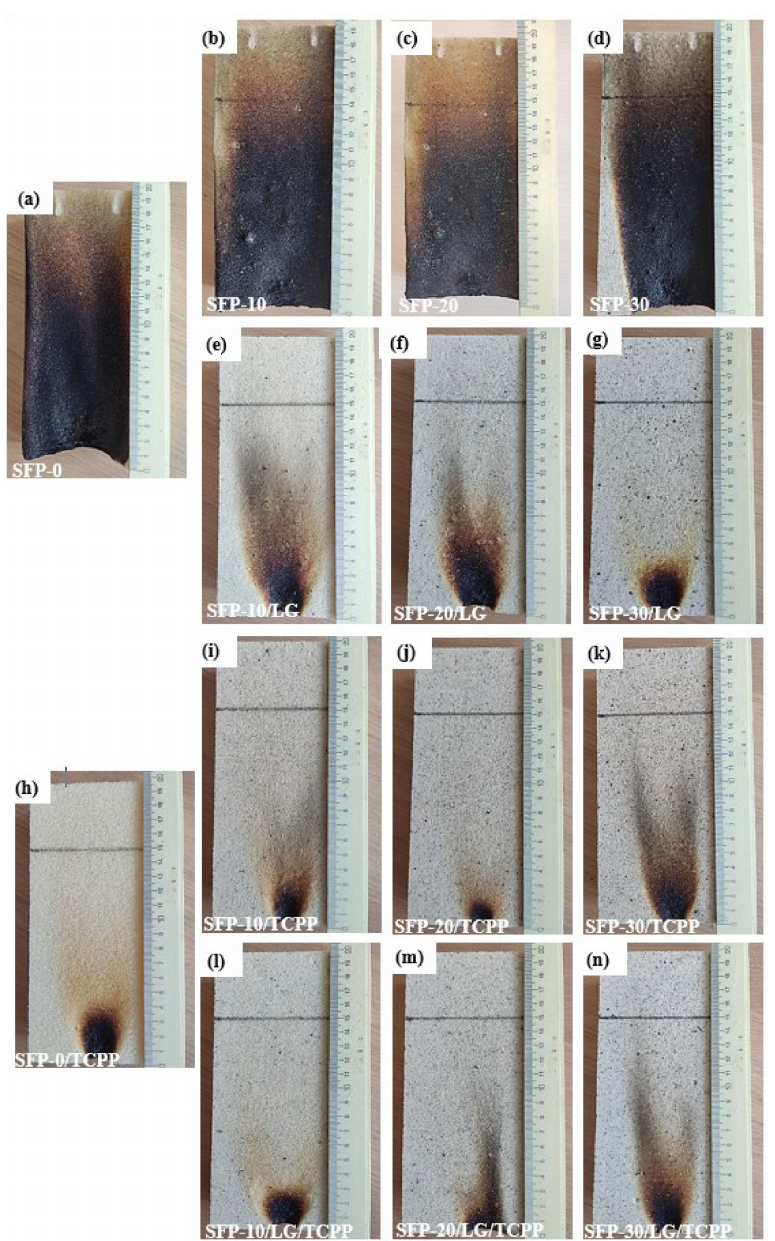
Figure 4. Ignitability experiment on: ( a ) SFP-0; ( b ) SFP-10; ( c ) SFP-20; ( d ) SFP-30; ( e ) SFP-10/LG; ( f ) SFP-20/LG; ( g ) SFP-30/LG; ( h ) SFP-0/TCPP; ( i ) SFP-10/TCPP; ( j ) SFP-20/TCPP; ( k ) SFP-30/TCPP; ( l ) SFP-10/LG/TCPP; ( m ) SFP-20/LG/TCPP; and ( n )